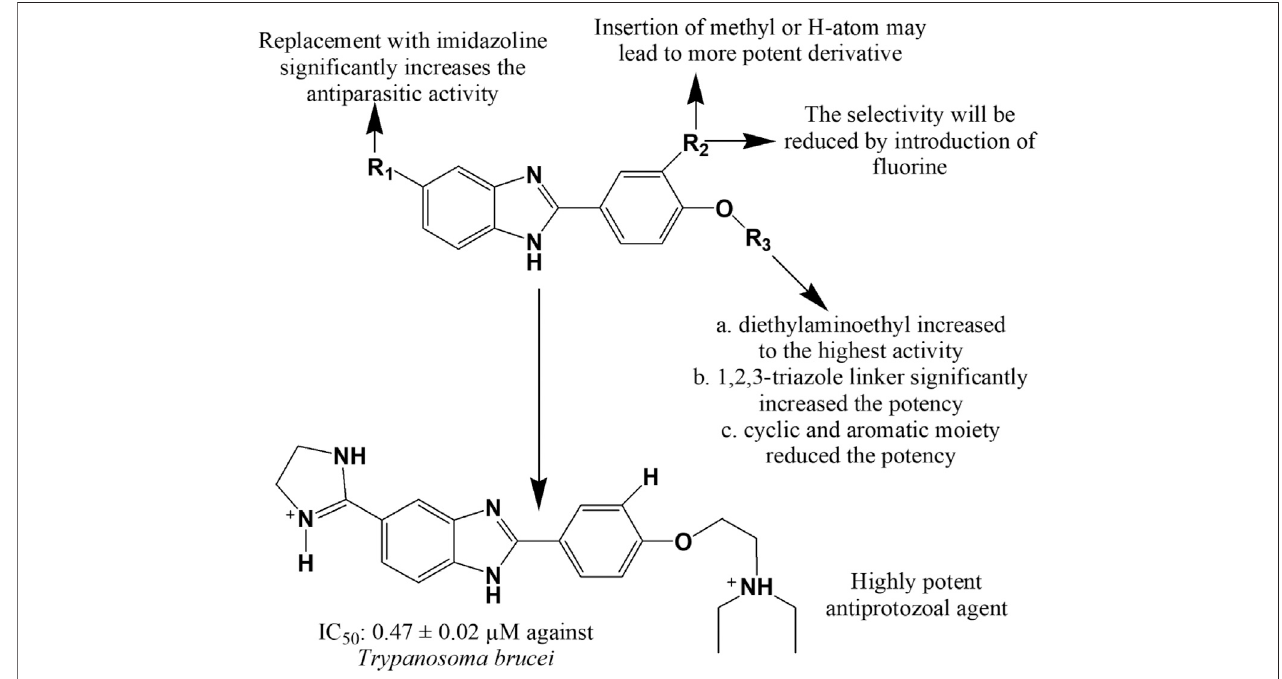
FIGURE 15 | Structure activity relationship (SAR) of benzimidazole derivatives effective against Trypanosoma brucei . The fi gure represents the SAR studies accomplished by Popov et al.